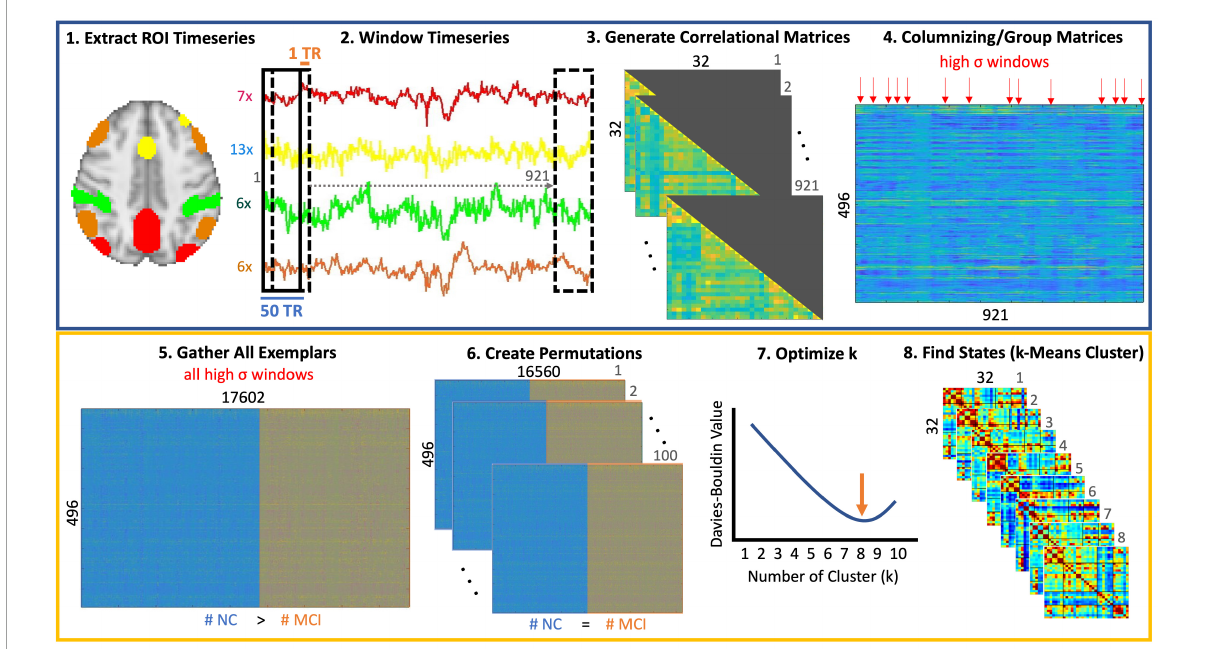
FIGURE1 Step-by-step brain state identification. (1) The preprocessed fMRI time series data was registered to MNI space. The resting-state networks masks for the default mode network (DMN), dorsal attention network (DAN), Salience network (Sal), and the Frontoparietal Network (FPN) were chosen from the Yeo atlas. Individual regions within each mask were delineated by intersecting these masks with regions of the Harvard Oxford Cortical and Subcortical Atlas in FSL. Seven regions (frontal pole, superior and inferior lateral occipital, juxtapositional lobule, cingulate, precuneus, cuneus) were identified for the DMN. The Salience network comprised of 13 regions (superior frontal, middle frontal, temporal pole, temporal pole, anterior and posterior supramarginal gyrus, subcallosum, cuneus, parietal operculum, planum polare, Heschl’s gyrus, supracalcarine cortex), the DAN had 6 regions (superior parietal, anterior and posterior supramarginal gyrus, angular gyrus, inferior lateral occipital, cuneus), and the FPN consisted of 6 regions (insula, middle frontal, inferior frontal, angular gyrus, inferior and superior lateral occipital) as well. (2) A sliding window of 50 TRs was used in this work with a stride length of 1 TR. (3) For each window, a correlation matrix was calculated and only the lower triangular matrix was retained due to the symmetric nature of connectivity matrices. (4) Since the window was only shifted by 1TR, there are likely redundant windows where connectivity patterns do not change significantly between neighboring windows. To reduce this redundancy, only windows, which were the most different from the preceding and following windows were considered. This